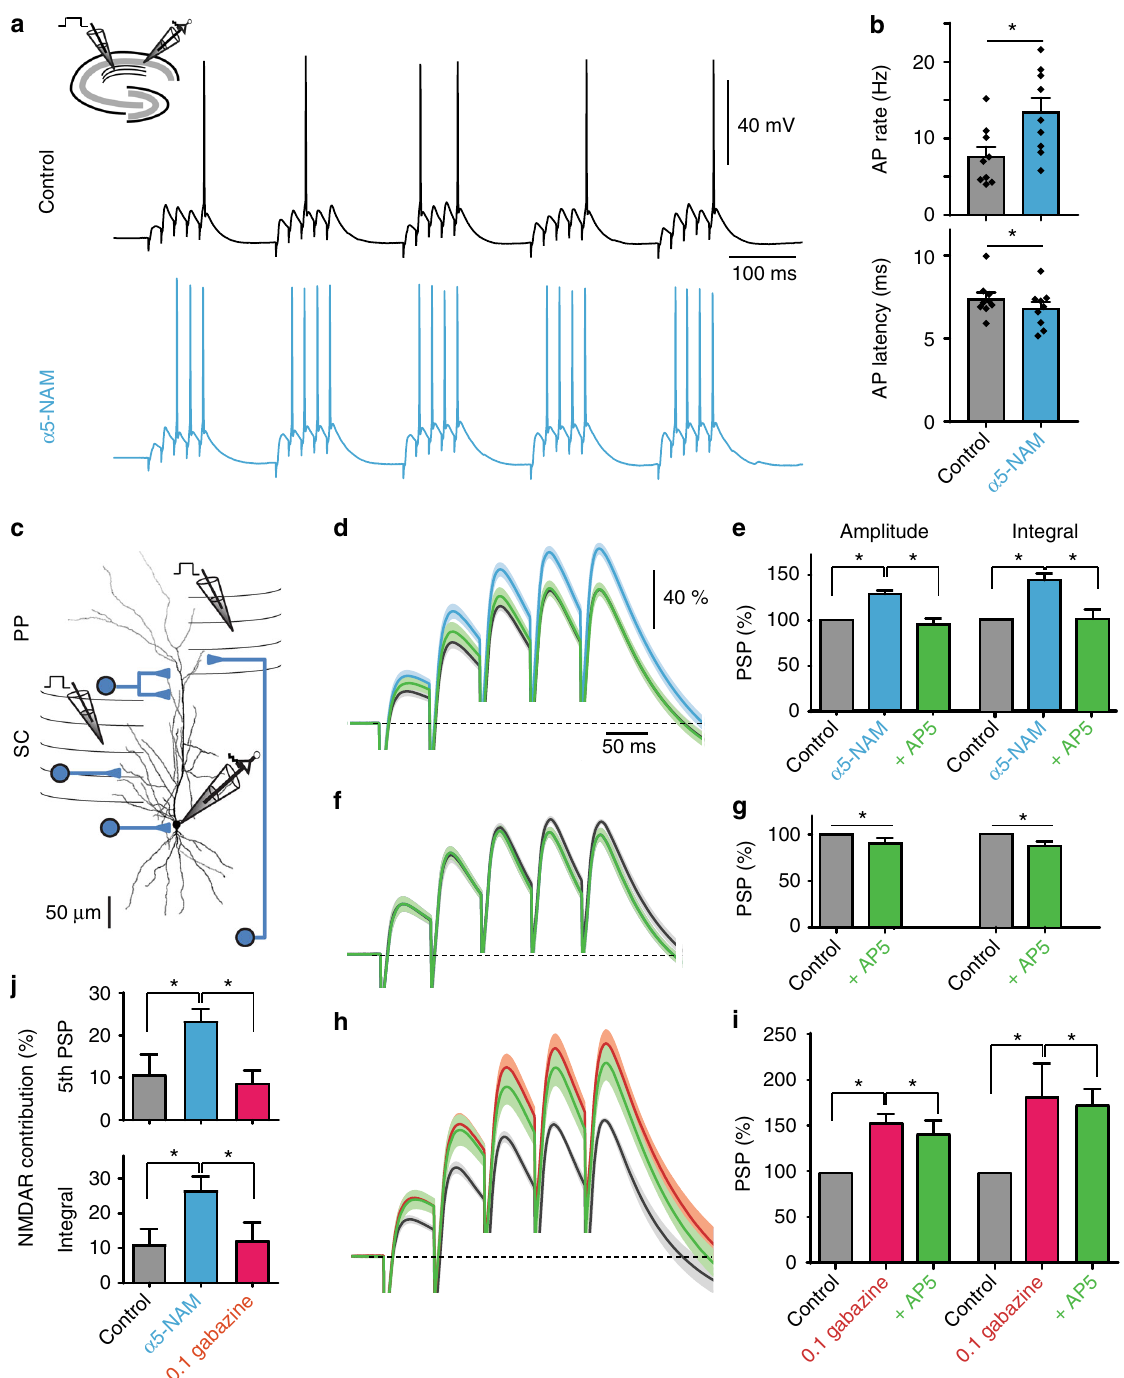
Fig. 2 Activation of α 5-GABA A Rs controls dynamic NMDAR recruitment. a Example voltage traces of theta-burst evoked AP fi ring during distant Schaffer- collateral (SC) stimulation before and after the addition of the α 5-NAM RO4938581 (1 µ M). Inset shows the experimental design. b Group means show a signi fi cantly increased spike rate ( P < 0.05; paired t test, n = 9) and decreased latency between stimulation and AP discharge ( P < 0.05; n = 9). c Experimental design for local stimulation of glutamatergic inputs from Schaffer collaterals (SC) and perforant path (PP) as well as associated GABAergic inputs. d Enhanced contribution of NMDARs after application of the α 5-NAM. The grand means with SEM (lighter shades) of 12 experiments are shown. Each mean was normalized to the maximal voltage de fl ection in the control condition (gray). Application of the α 5-NAM (1 µ M) increased the burst PSP (blue). The addition of AP5 (50 µ M, green) completely reversed this effect. e Group means of the amplitude and integral of the burst PSP. Statistical signi fi cant differences are indicated ( P < 0.001; paired t test, n = 12). f , g Application of AP5 (50 µ M, green) in the absence of α 5-NAM caused much smaller changes in amplitude and integral ( P < 0.05; paired t test, n = 8). h , i Application of low concentration of gabazine (0.1 µ M, red) increased amplitude and integral to a comparable degree as α 5-NAM ( P < 0.01; paired t test, n = 8). Yet the relative effect of subsequent AP5 application was much weaker. j The relative contribution of NMDAR-mediated depolarization was signi fi cantly higher after the addition of the α 5-NAM than under control conditions or after the addition of 0.1 µ M gabazine (all: P < 0.05; two-sample t test). T ≈ 33